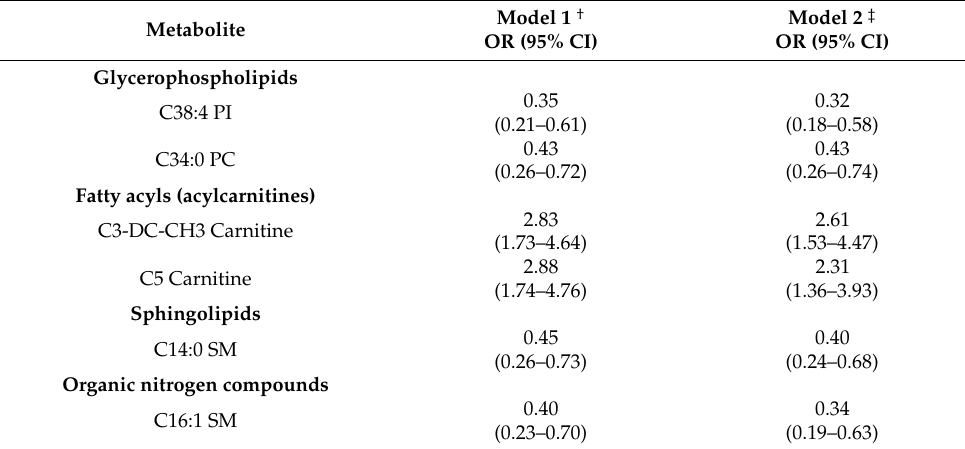
* ORs based on conditional logistic regression models with metabolite percentiles based on the distribution in controls on the log metabolite intensity scale; table includes only metabolites for which the false discovery rate was <0.20. † Model was adjusted for age, sex, race, cigarette smoking status, alcohol consumption, and family history of renal cancer. ‡ Model was adjusted for model 1 covariates, plus body mass index, physical activity, history of diabetes, and history of